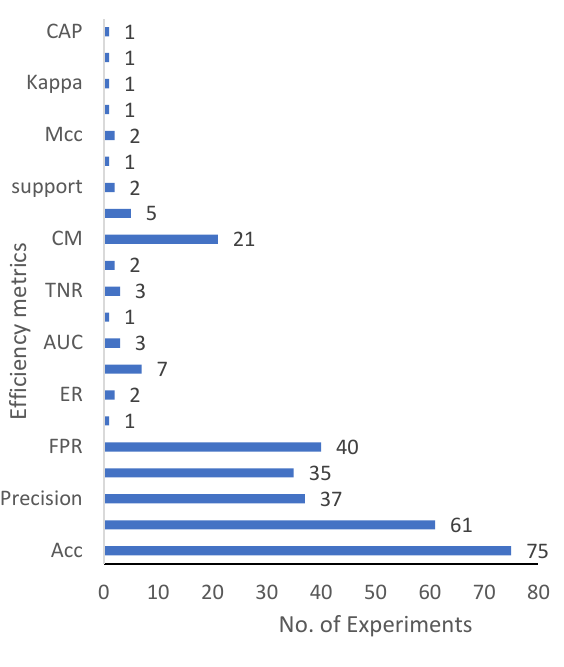
Figure 4 Evaluation